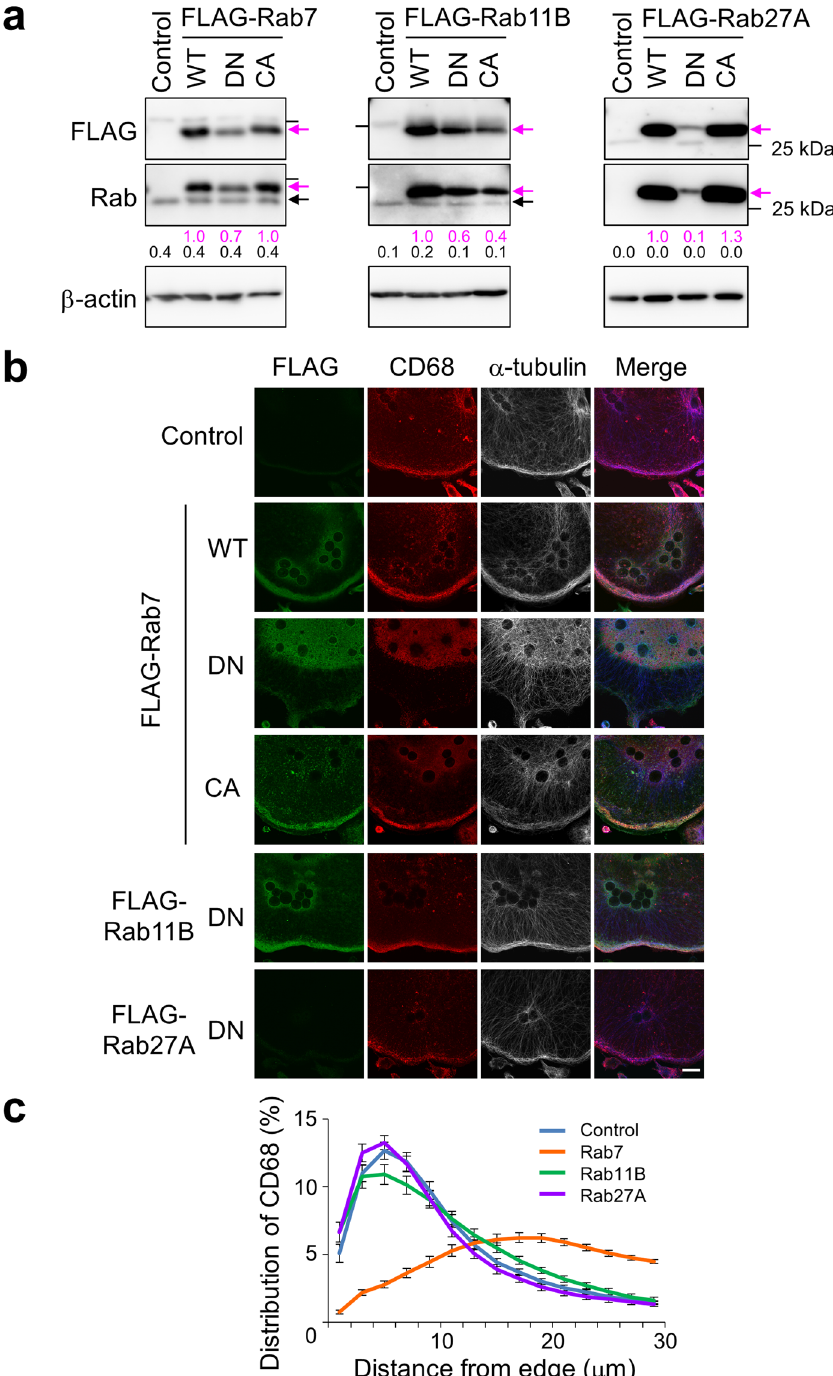
Figure 6. Effects of Rab small GTPases on the peripheral localisation of CD68. ( a ) Expression of various Rab proteins in osteoclasts. Splenic macrophages from wild-type mice were infected with a retrovirus carrying a gene encoding FLAG-tagged Rab7 (left panels), Rab11B (middle panels) or Rab27A (right panels) and cultured with RANKL for 6 days. Then, osteoclast lysates were electrophoresed through an acrylamide gel. FLAG-Rab proteins were detected with antibodies specific for FLAG (upper panel, magenta arrows) and each Rab protein (middle panel, magenta arrows). Endogenous Rab proteins (middle panel, closed arrows) and β -actin (lower panel) were also detected using corresponding antibodies. WT, DN and CA indicate cells expressing wild-type, dominant-negative (GDP-bound) and constitutively active (GTP-bound) Rab proteins, respectively. Control indicates cells infected with an empty vector. Bars indicate the position of the 25 kDa molecular mass marker. Numbers below blots represent relative signal intensities of FLAG-tagged (magenta) and endogenous (black) Rab protein normalised to that of FLAG-tagged wild-type Rab protein. Unprocessed scans of immunoblots are shown in Supplementary Fig. S6. ( b ) Effects of Rab protein expression on the peripheral localisation of